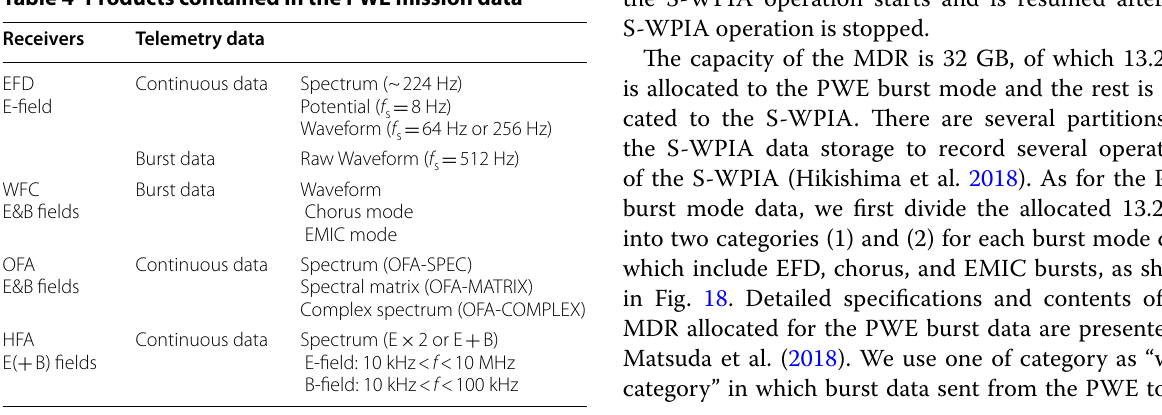
Table 4 Products contained in the PWE mission